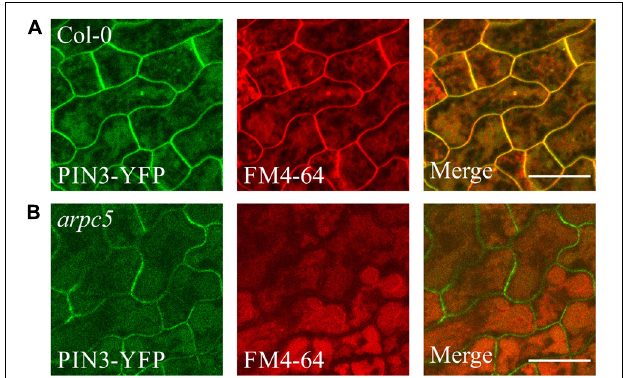
FIGURE 8 | PIN3-YFP localization to the vacuole in 3DAG wild type (A) and arpc5 (B) seedlings. 2DAG plants expressing pPIN3::PIN3:YFP were incubated in darkness overnight in a solution of 4 µ M FM4-64 to allow for vacuolar staining (scale bar = 20 µ m).